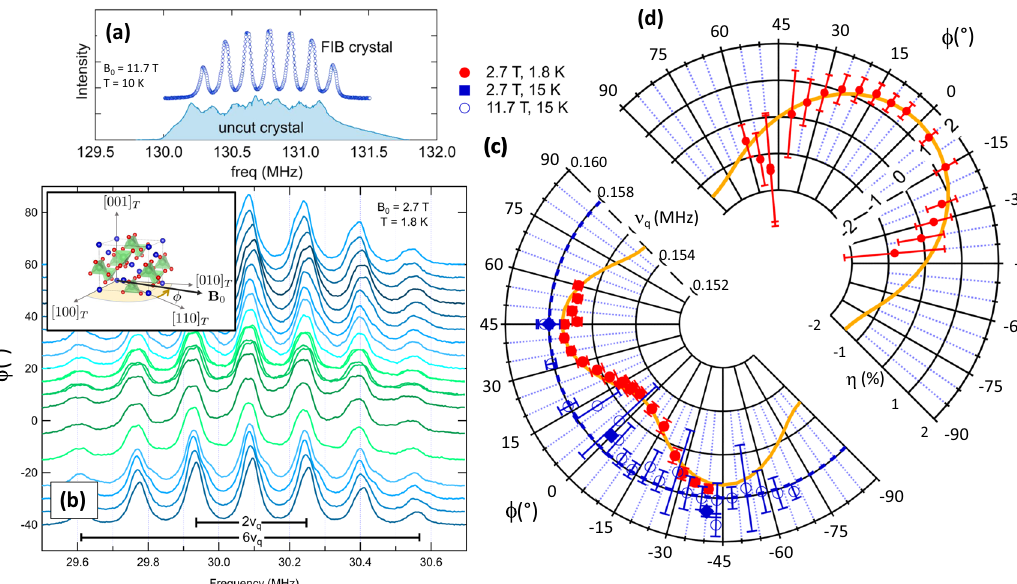
Fig. 1 NMR spectra for in-plane fi elds. a 51 V spectra of ellipsoidal (FIB) and uncut samples measured at T = 10 K and B 0 = 11.7294 T oriented perpendicular to c , illustrating the broadening effect of the inhomogeneous demagnetization fi eld on the seven nuclear spin transitions. b Spectra as a function of in-plane fi eld angle, ϕ , measured at 2.7 T and 1.8 K. Colors correspond to ϕ modulo 90 ∘ . INSET: Diagram of fi eld orientation with respect to the tetragonal unit cell, with the angle ϕ being measured from the [110] T direction. Blue atoms are Tm, green are V, and red are oxygen. c Polar plot showing the average quadrupolar splitting, ν q , as a function of in-plane angle, ϕ , at 2.7 T and 1.8 K (solid red circles), 2.7 T and 15 K (solid blue squares) and 11.7 T and 15 K (open blue circles). The solid yellow line is a fi t as described in the text, and the dashed line is a guide to the eye assuming tetragonal symmetry with no in-plane anisotropy ( η = 0). d The ϕ -dependence of η at B = 2.7 T and T = 1.8 K. The solid yellow line is given by η ð ϕ Þ ¼ η 0 cos ð 2 ϕ Þ with η 0 = 1.44%. Thus η ( ϕ ) switches sign from positive to negative as the fi eld is rotated from 0 ∘ to 90 ∘ . Error bars are standard